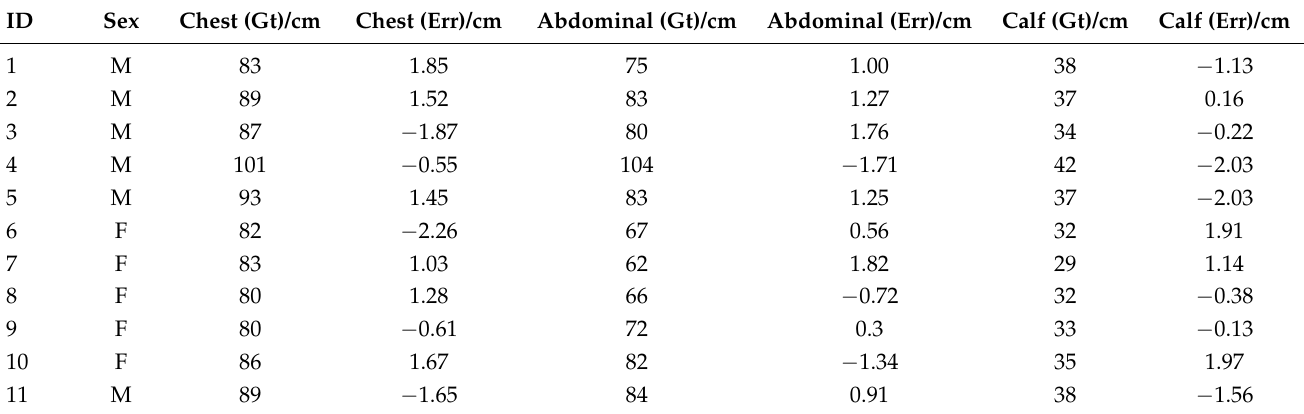
Table 4. Results and error analysis of size measurement: chest girth, abdominal girth and calf girth. (Gt) means ground truth; (Err) means the deviation between the estimated size and the ground